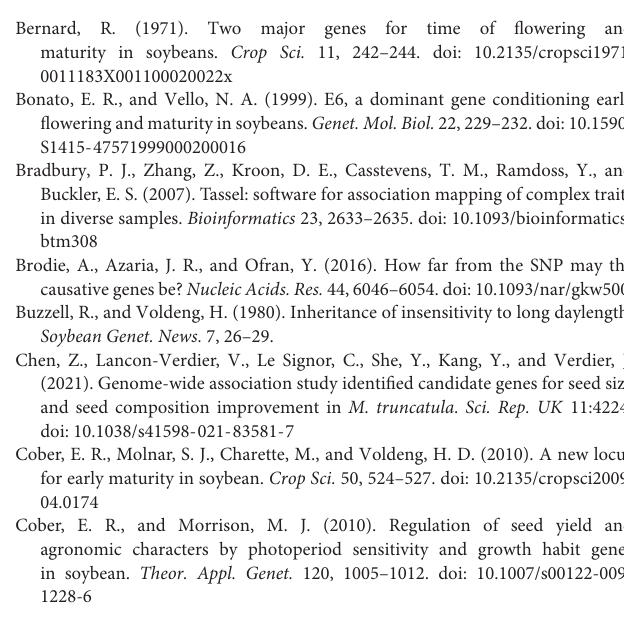
Supplementary Table 2 | SNP associated with four GSTs in summer soybeans. Supplementary Table 2.1 | SNP associated with days to flowering of summer soybeans. Supplementary Table 2.2 | SNP associated with days to pod beginning in summer soybeans. Supplementary Table 2.3 | SNP associated with days to seed formation in summer soybeans. Supplementary Table 2.4 | SNP associated with days to maturity initiation in summer